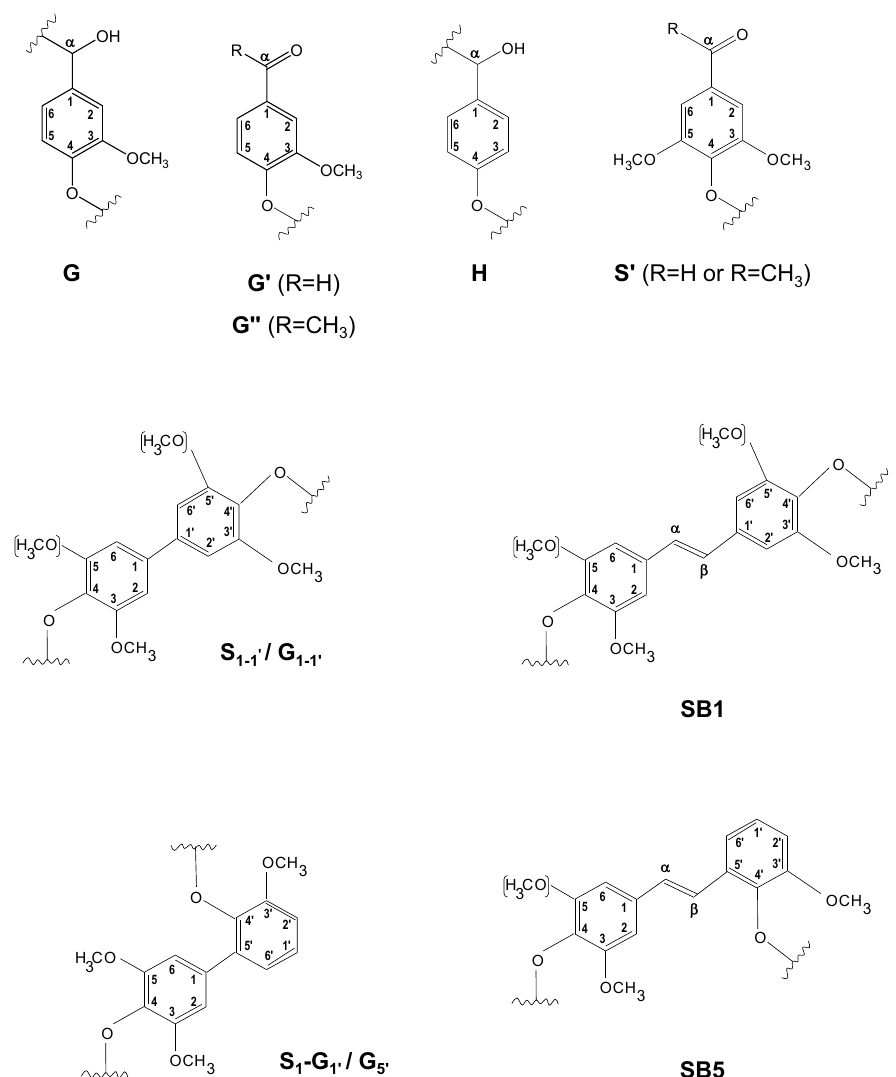
Figure 3. Main lignin substructures identified in aromatic region of untreated and laccase ‐ treated Kraft lignins with MtL and SiLA laccases. G , guaiacyl unit; G ′ , vanillin; G ″ , acetovanillona; H , p ‐ hydroxyphenyl unit; S , syringyl unit; S ′ , syringaldehyde (R=H) or acetosyringone (R=CH 3 ); S 1–1 ′ , 3,5 ‐ tetramethoxy ‐ para ‐ diphenol; G 1–1 ′ , 3 ‐ dimethoxy ‐ para ‐ diphenol; S 1 ‐ G 1 ′ /G 5 ′ ; SB1 , stilbene ‐β‐ 1 ′ ; SB5 , stilbene ‐β‐ 5 ′ .